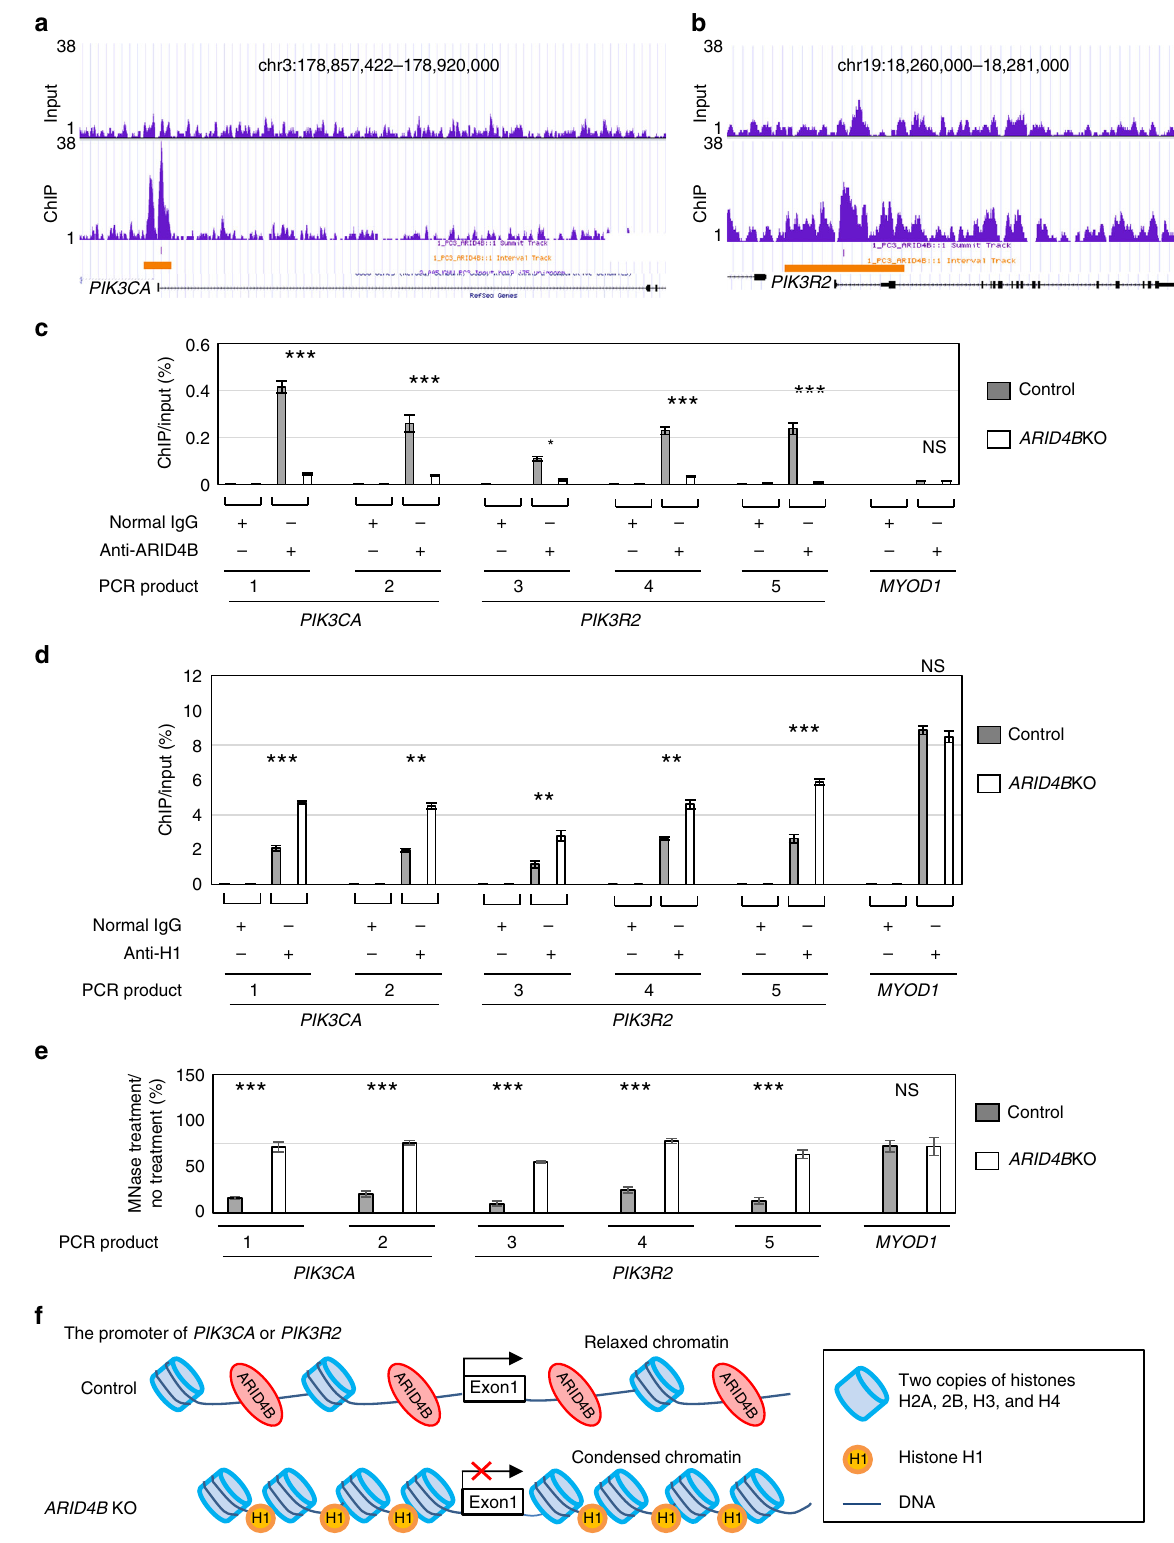
data demonstrate a synthetic essentiality of ARID4B in prostate (Supplementary Fig. 9a). Similar to the results from 5-month-old mice, only normal/hyperplasia and PIN were found in the Pten PC − / − Arid4b PC − / − mice (Supplementary Fig. 9b, c). These results suggest that in the Pten PC − / − Arid4b PC − / − mice, PIN did not progress to adenocarcinoma over time. Collectively, these NATURE COMMUNICATIONS| (2019) 10:4332